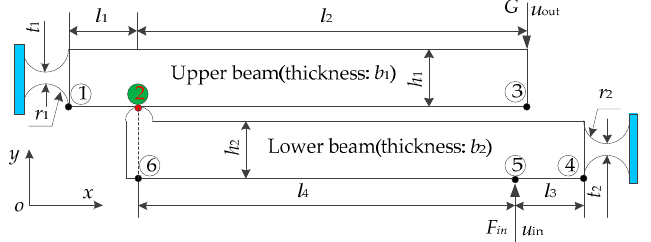
Figure 3. Simplified structural schematic of the two-stage flexural hinge lever-type mechanism. The upper beam and lower beam are of a mutual contact at point 2. Table 1. Symbols used in the calculation modeling.